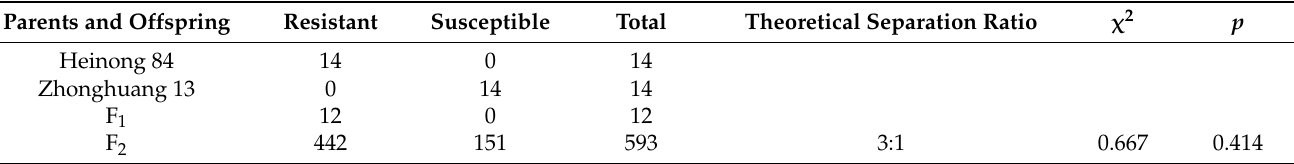
Figure 1. Resistance of Heinong 84, Zhonghuang 13, and their hybrid F 2 offspring. ( a ) Phenotypes of systemic leaves of Heinong 84 and Zhonghuang 13 inoculated by buffer (mock) or SMV N3 at 20 dpi. ( b ) Bar chart showing the distribution of the F 2 populations in different disease indices. Table 2. Genetic analyses of the resistance of the two parents and their hybrid populations to SMV N3.